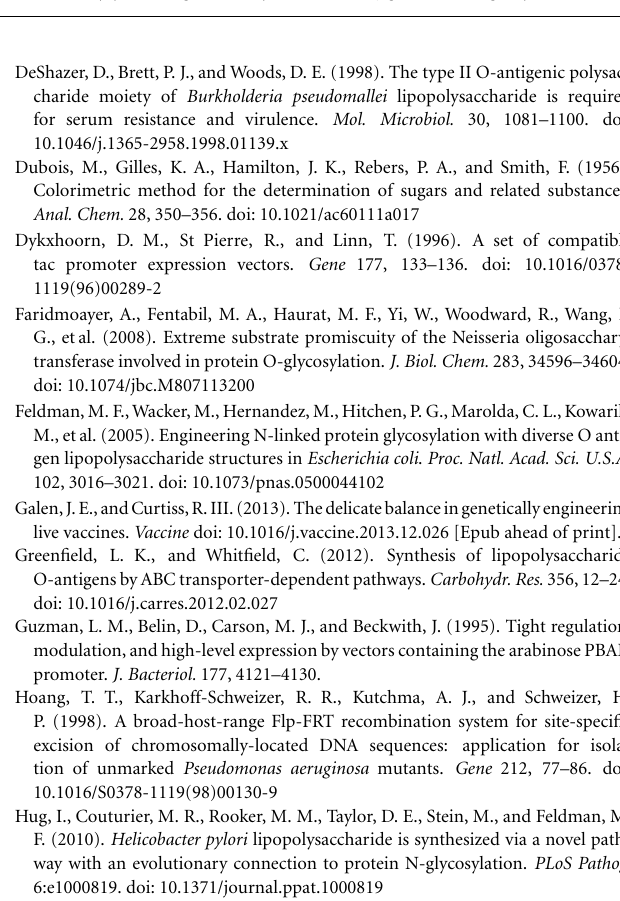
FIGURE 7 | Murine survival of different test groups to a 12 × LD 50 i.n. challenge of B. pseudomallei . Mice vaccinated with either PBS or unglycosylated AcrA controls had a significantly lower survival period as